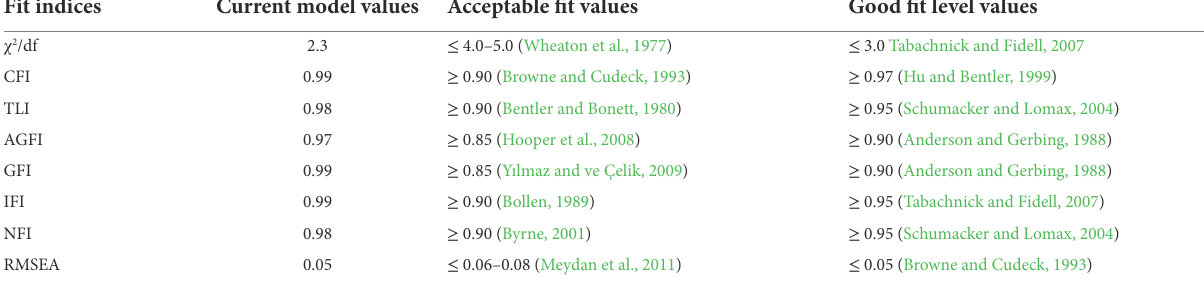
TABLE 4 CFA model fit indices for perceived academic intent to entrepreneurship (PAIE scale).